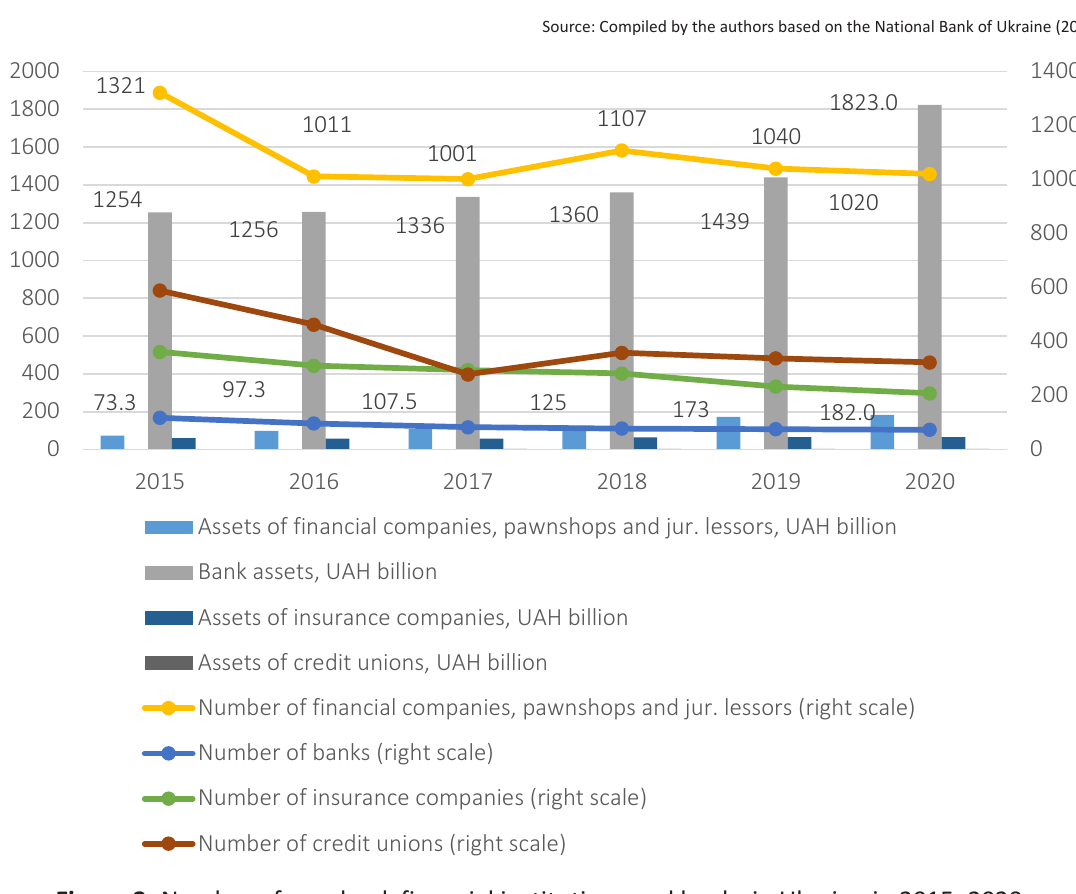
Figure 1. The number of credit unions and banks in the United States in 2004–2020